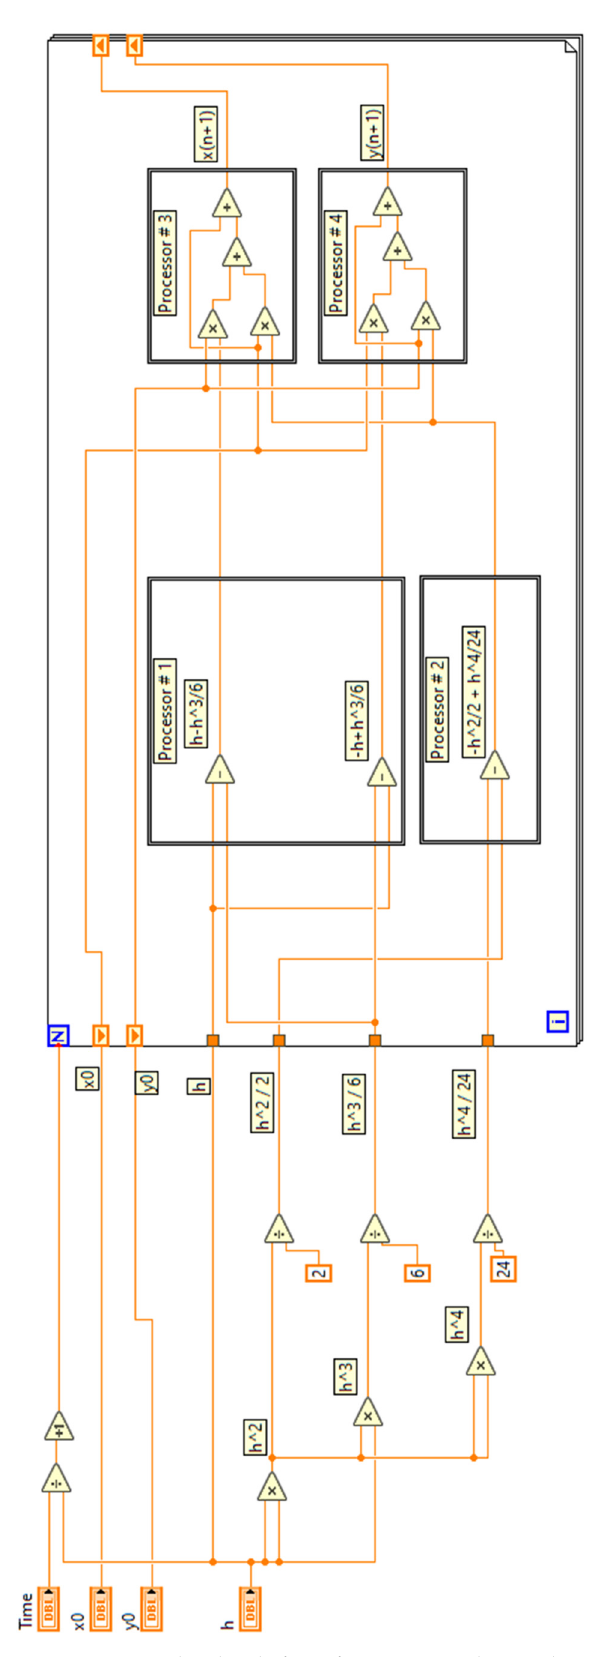
Figure A3. Graphical code for software ODE solver with parallel 2-processor computational structure for test problem (17). Floating point data type used.